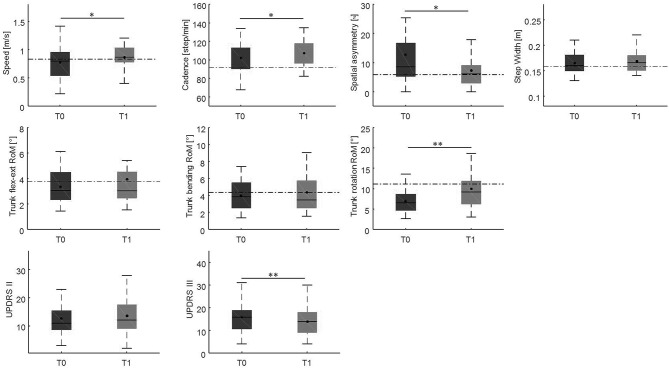
This figure shows the time-distance parameters, spatial symmetry index, and trunk kinematics at baseline and at the 10-week follow-up. For each box, the central black horizontal line indicates the median, the central black dot denotes the mean, and the bottom and top edges of the box indicate the 25 and 75th percentiles, respectively. Whiskers extend to the most extreme data points not considered outliers. Asterisks denote statistically significant differences (*p < 0.05; **p < 0.01). Black horizontal dashed lines represent the mean of each parameter in the healthy control group. flex-ext, flexion-extension; RoM, Range of Motion; T0, baseline; T1, 10-weeks follow-up.